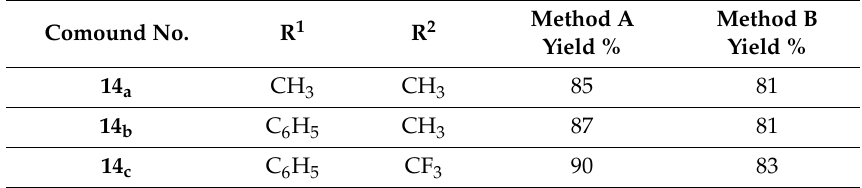
Table 4. Yield comparison of triethylamine and ammonia methods for synthesis of deprotected galactosides ( 14 a–c ).